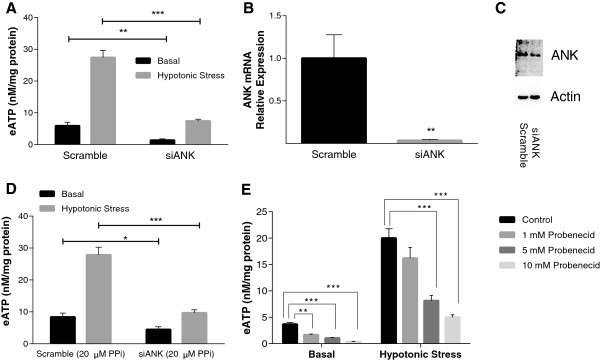
Role of progressive ankylosis gene product (ANK) in basal and hypotonically stressed eATP release from chondrocytes. For the following experiments, a hypotonic challenge was initiated by removing 35 μl of media, replacing it with 35 μl of H2O. eATP levels were measured after 10 minutes. Under control conditions, hypotonic challenge consistently increases eATP. Bars represent mean ± standard error; n = 8 for all analyses. (A) Chondrocytes were transfected with siRNA for ANK or scramble control. After 48 h, cells were exposed for 10 minutes to hypotonic (gray bars) or isotonic (black bars) media and eATP levels were measured. siANK suppressed eATP levels under basal and hypotonically challenged conditions (**P <0.01). (B, C) In parallel cultures at 48 h, mRNA and protein were isolated to assess levels of ANK mRNA (**P <0.01) and protein. Western blots compared effects on ANK versus actin. (D) Transfected chondrocytes (as described above) were exposed to media containing no additives (control) or 20 μM PPi in 100 μl of media for 30 minutes with or without hypotonic challenge. The addition of PPi did not alter eATP levels compared to controls without PPi (P >0.05). (E) Chondrocytes were treated with no additives (control), 1 mM probenecid, 5 mM probenecid or 10 mM probenecid (as described above). After the hypotonic challenge eATP levels with 1 mM probenecid were not statistically different from the control (P >0.05): 5 to 10 mM probenecid decreased eATP levels in basal and hypotonically challenged states (**P <0.01, ***P <0.001).